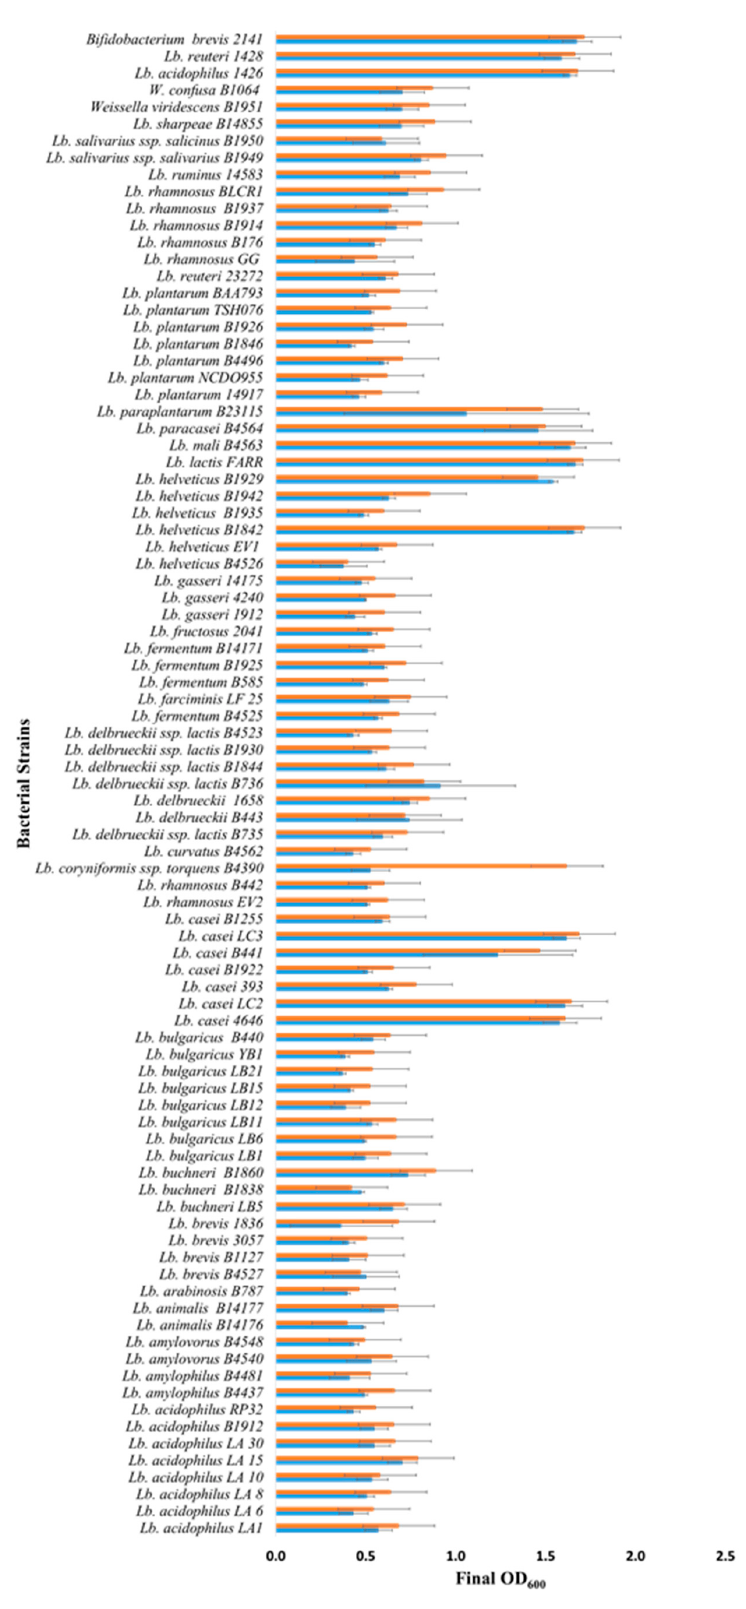
Figure 1. Growth of Lactobacillus and Bifidobacterium strains in mMRS broth (no glucose) supple- mented with 1% FOS (blue bars) or inulin (orange bars) under anaerobic conditions. Bars represent the average optical density (600 nm) after incubation at 32 °C for 18–24 h (± standard deviation).